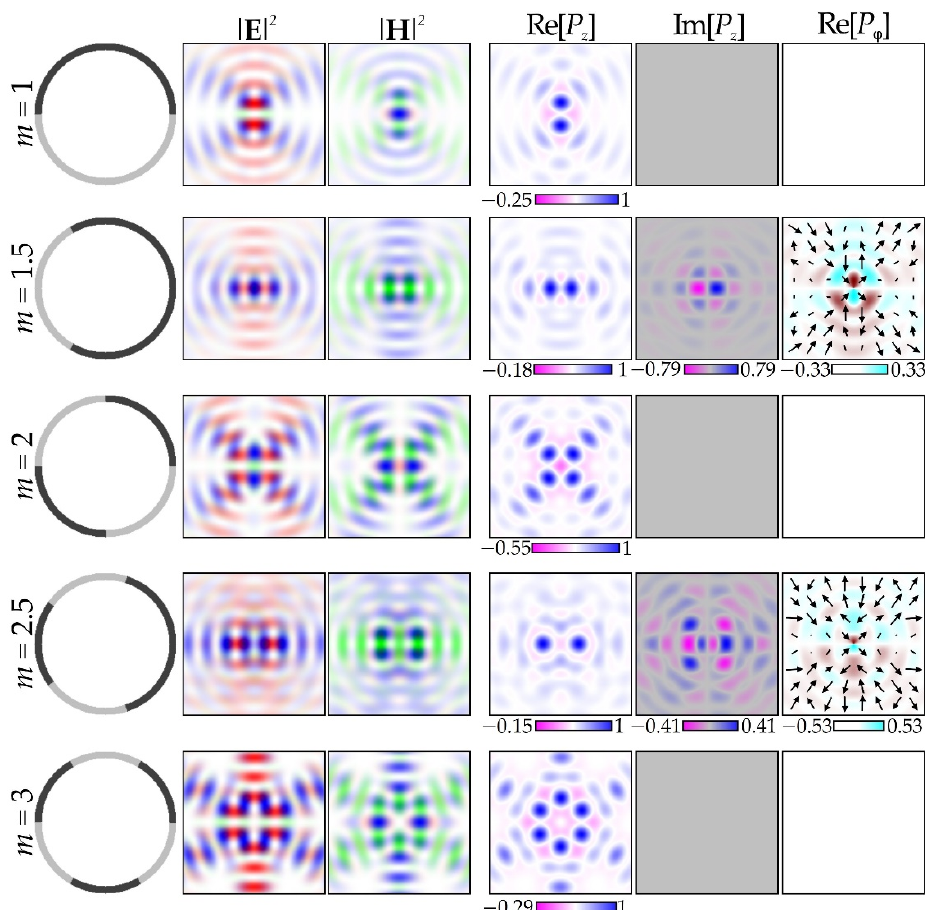
Figure 7. Simulation results for binary phases (red color—for x -components, green color—for y - components, and blue color—for z -components). The distributions in the focal plane with a size of 4 λ × 4 λ are shown.